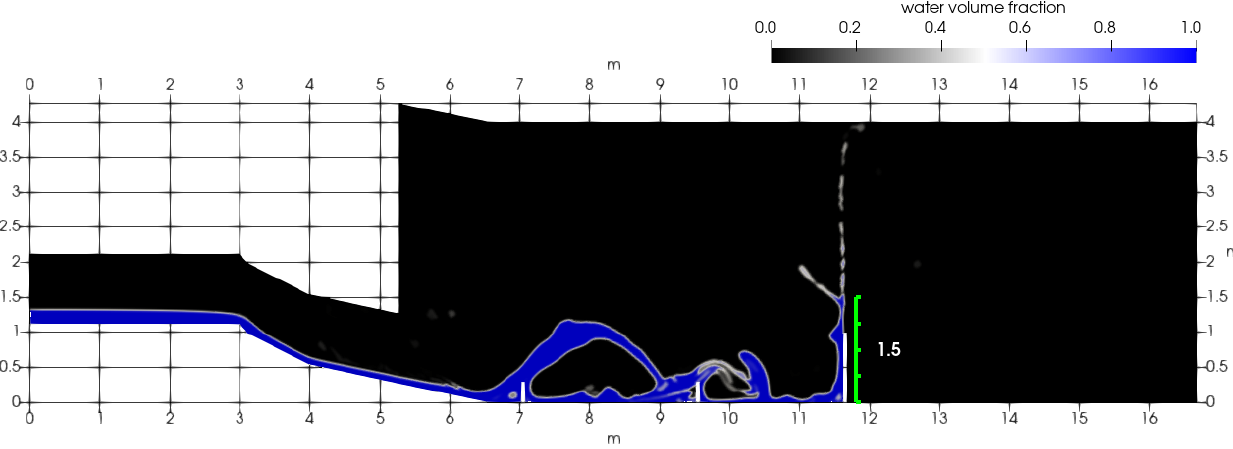
Figure 8. The interaction of the flow with three dams (simulation). There are splashes and formation of jets on the dams. The colors are related to the values of α (i.e., the relative part of the cell occupied by liquid) : blue—1, black—0. White lines are